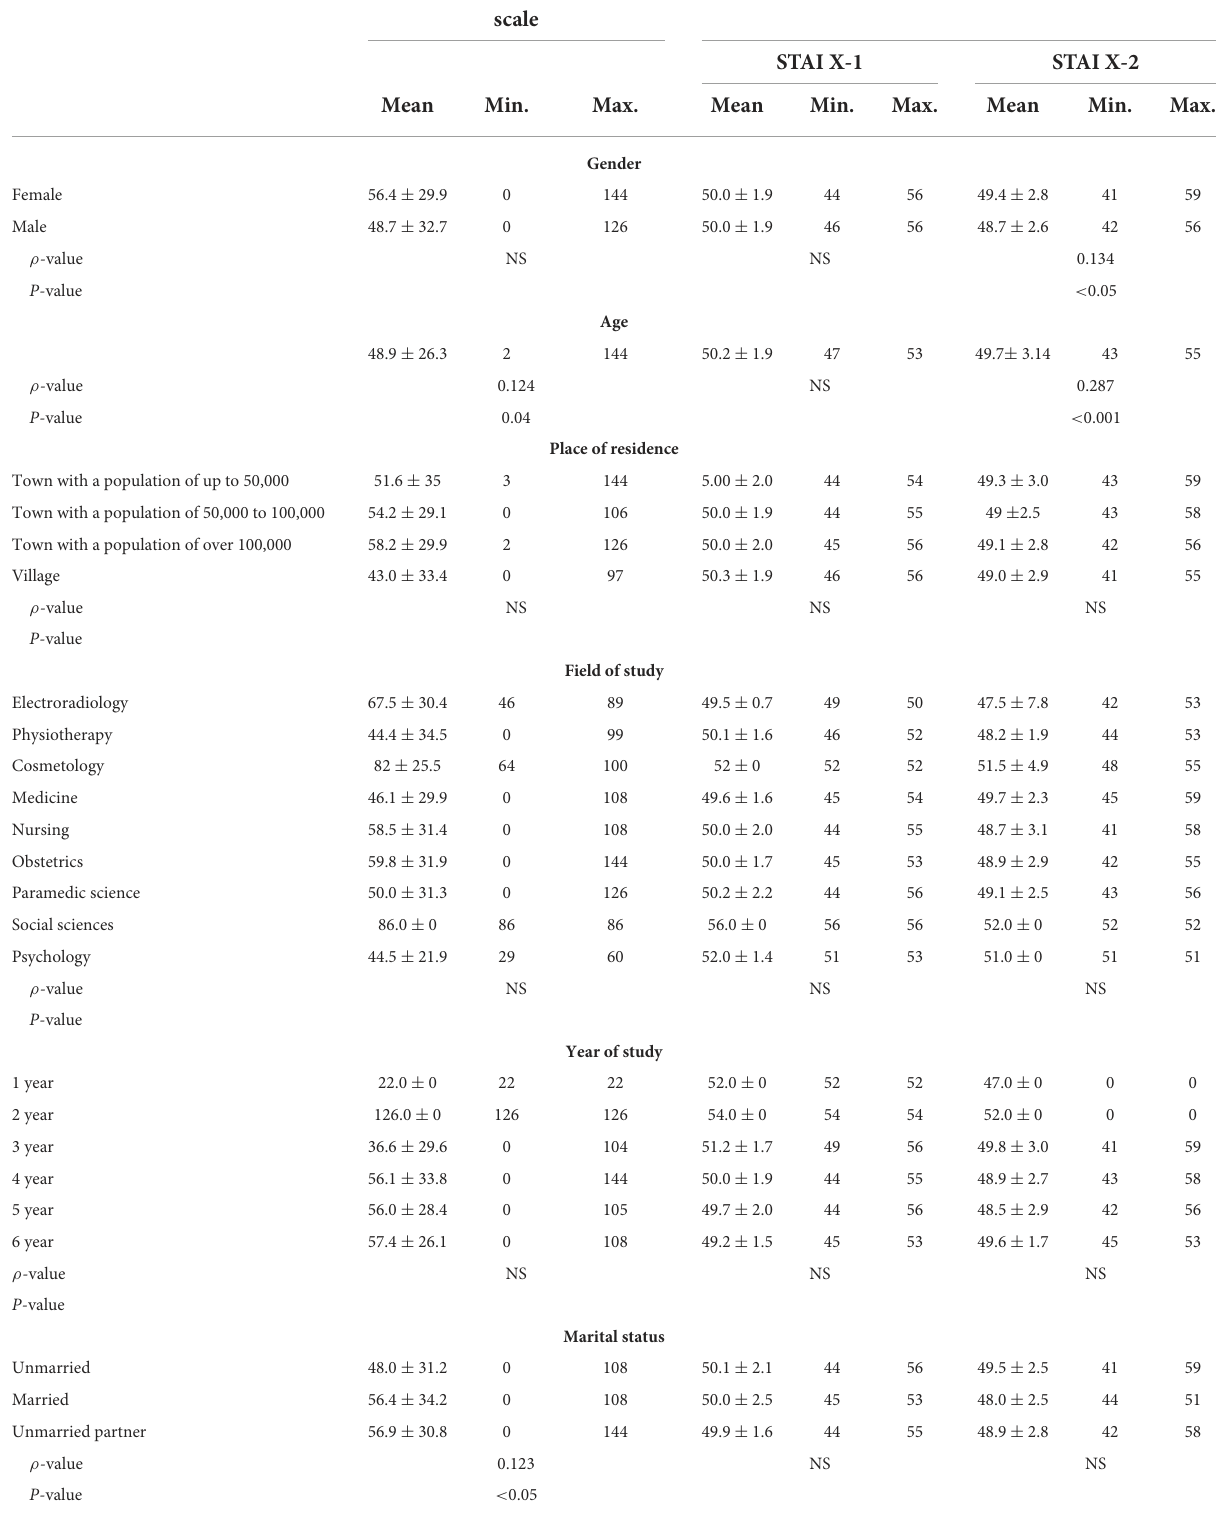
TABLE 2 Levels of social anxiety, state anxiety (X-1), and trait anxiety (X-2) according to gender, age, place of residence, field of study, year of study, and marital status. Liebowitz social anxiety State-trait anxiety inventory scale STAI X-1 STAI X-2 Mean Min. Max. Mean Min. Max. Mean Min. Max. Gender